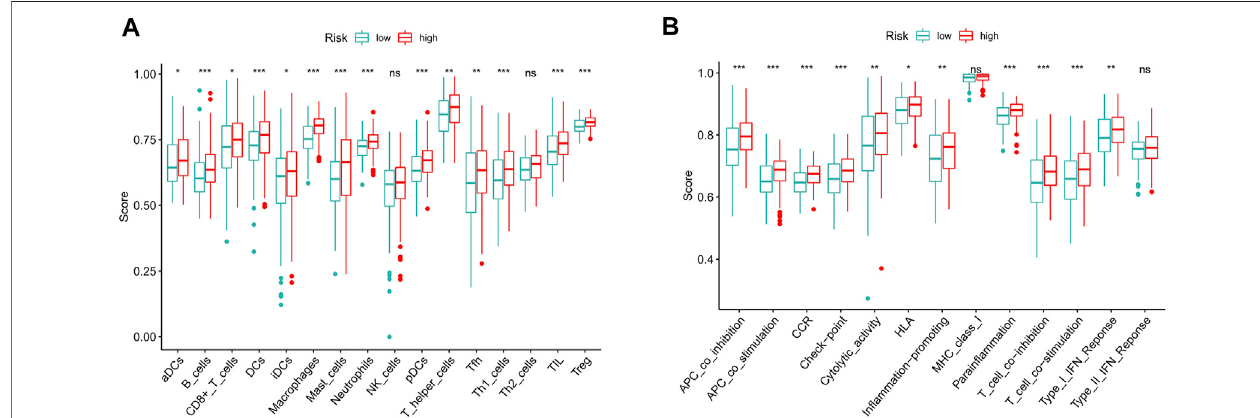
FIGURE 9 | The scores of immune in fi ltrating cells and immune-related functions in high- and low-risk groups. (A) ssGSEA algorithm was used to calculate the in fi ltration levelsof16immunecellsinhigh-and low-riskgroups. (B) Thecorrelation betweenthepredictivesignatureand13immune-relatedfunctions.ssGSEA, single- samplegenesetenrichmentanalysis;aDCs,activateddendriticcells;iDCs,immaturedendriticcells;NK,naturalkiller;pDCs,plasmacytoiddendriticcells;Tfh,Tfollicular helper;Th1,Thelpertype1;Th2,Thelpertype2;TIL,tumor-in fi ltratinglymphocyte;Treg,Tregulatorycell;APC,antigen-presentingcell;CCR,chemokinereceptor; HLA, human leukocyte antigen; MHC, major histocompatibility complex; IFN, interferon. * p < 0.05; ** p < 0.01; *** p < 0.001; ns, non-signi fi cant.